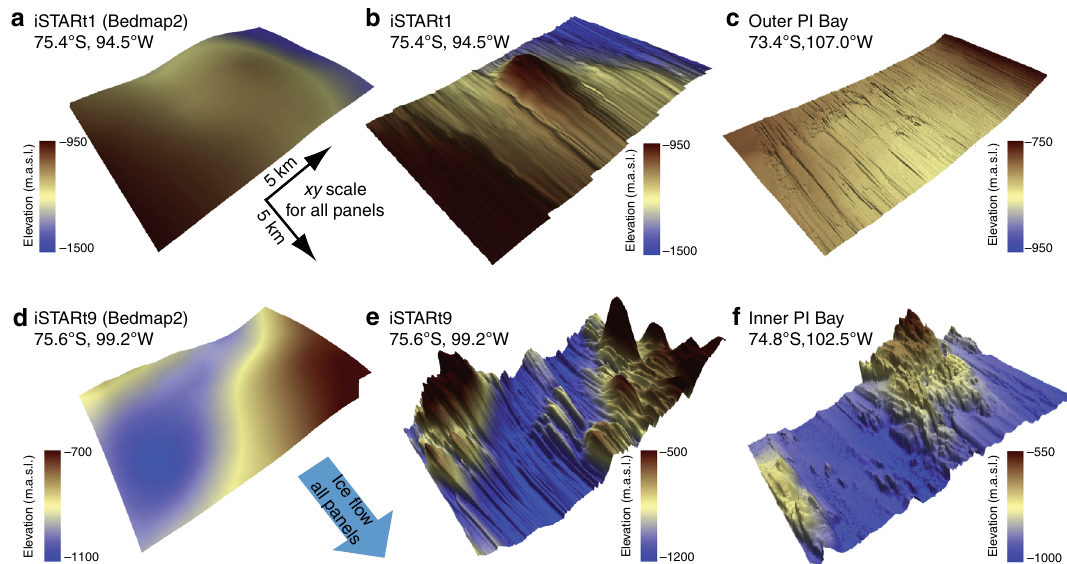
Fig. 2 Comparison of surveyed beds beneath Pine Island Glacier with those used in ice-sheet modelling and imaged in selected palaeo-ice-streams. a Bed topography at site iSTARt1 (location in Fig. 1) from previous knowledge 23 . b New bed topography (alternative perspective view to Fig. 1e). c Analogous subsample of bed topography from outer Pine Island Bay imaged from data presented in ref. 27 ; patch location marked on Fig. 1b. d Bed topography at site iSTARt9 (location in Fig. 1) from previous knowledge 23 . e New bed topography (alternative perspective view to Fig. 1l). f Analogous subsample of bed topography from inner Pine Island Bay imaged from data presented in ref. 29 ; patch location marked in Fig.